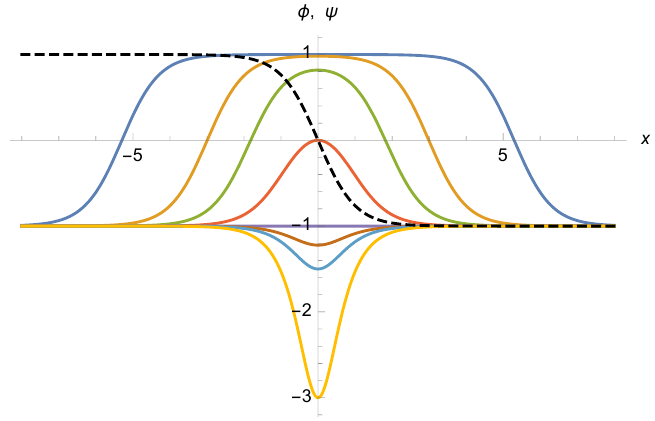
Figure 1 . Solutions in the nontrivial sector: dashed line - φ 0 ( x ; a = 0) = − tanh( x ) ; solid lines - ψ 0 ( x ; a = 0 , b ) for several values of b